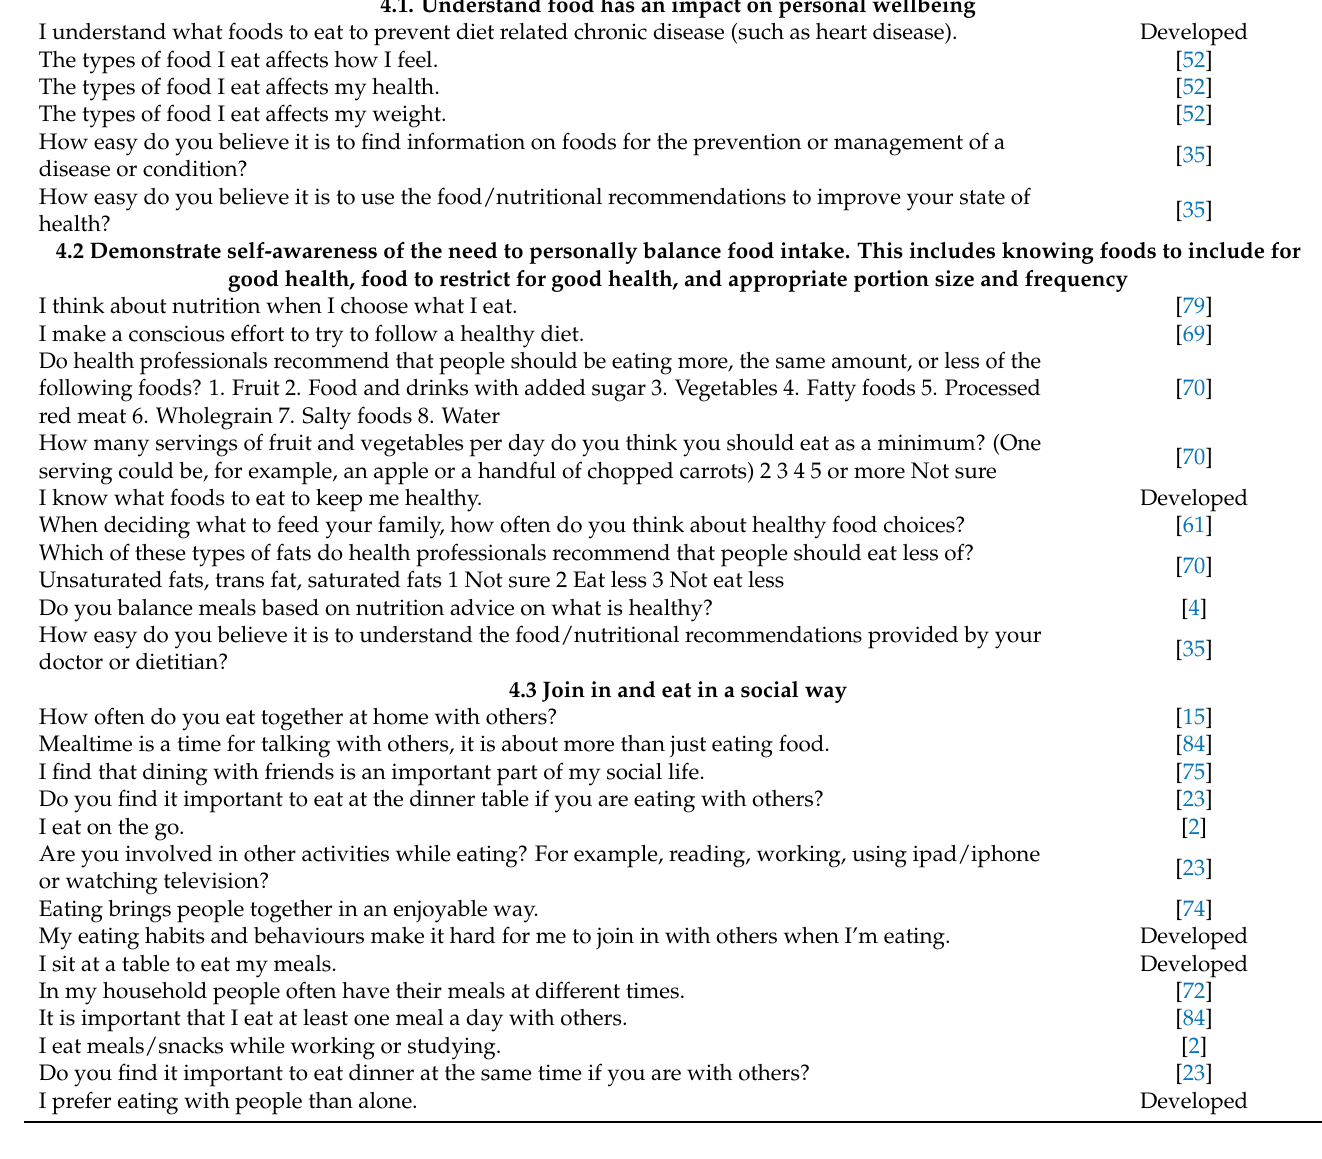
Table 3. Cont. Item